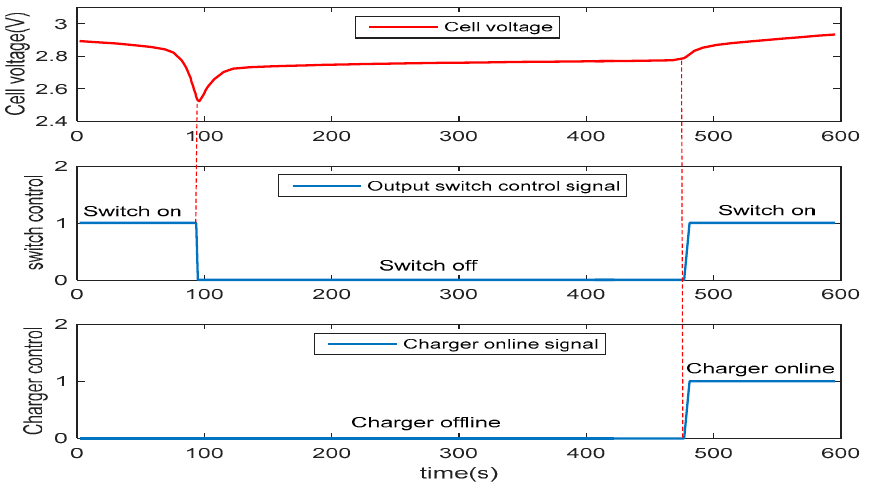
Figure 17. Over-discharged fault detection and self-recovery curve.